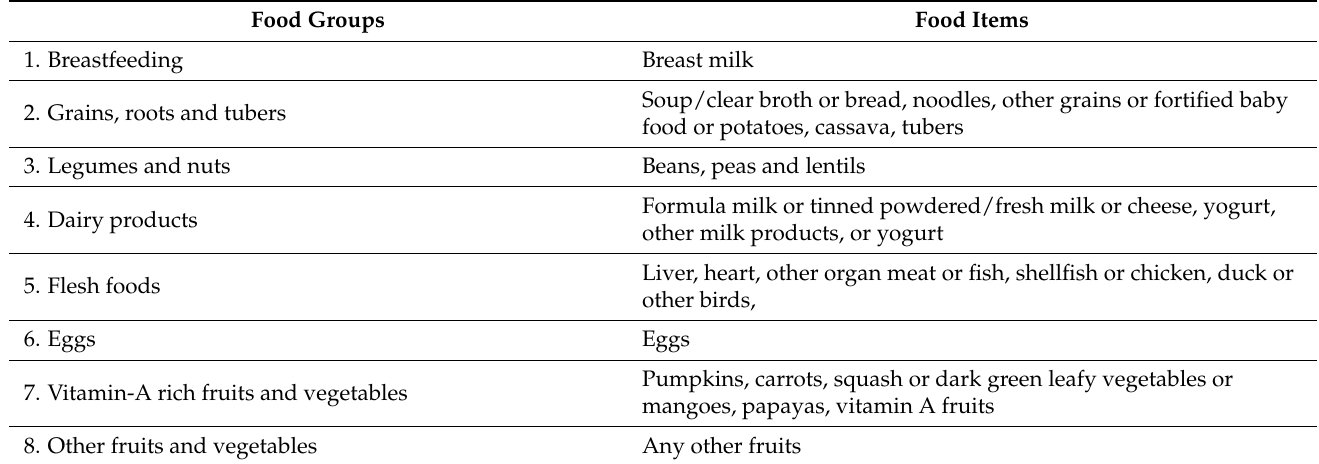
Table 1. The eight food groups used for dietary diversity score